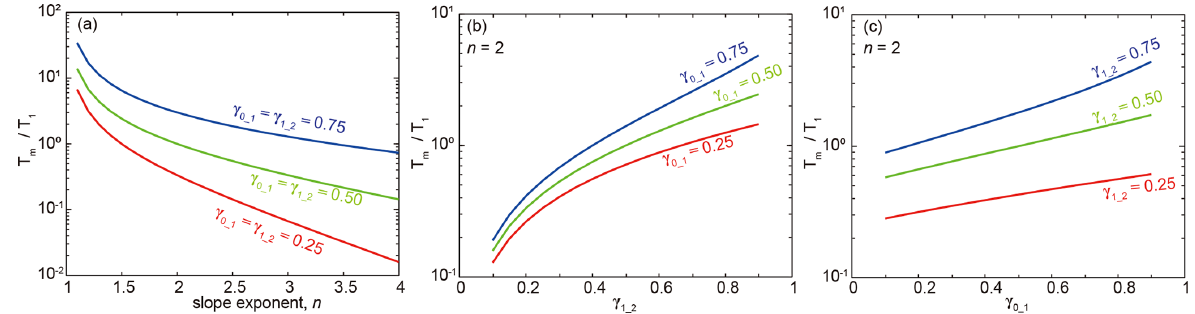
Figure 2. The duration of convex knickpoint preservation as a function of slope exponent n (a) , γ 1_2 (b) and γ 0_1 (c) . In (a) , the steepness ratios are equal, γ 1_2 = γ 0_1. In (b) and (c) , n = 2. The analysis assumes two knickpoints, kp 1 (upper) and kp 2 (lower), generated by two step increases in tectonic uplift rates, T 1 corresponds to the duration between the formation of kp 1 and the formation of kp 2 , and T m corresponds to the time from the emergence of kp 2 to its merging with kp 1 . γ 1_2 is the ratio of steepness indices above and below kp 2 , and γ 0_1 is the ratio of steepness indices above and below kp 1 .